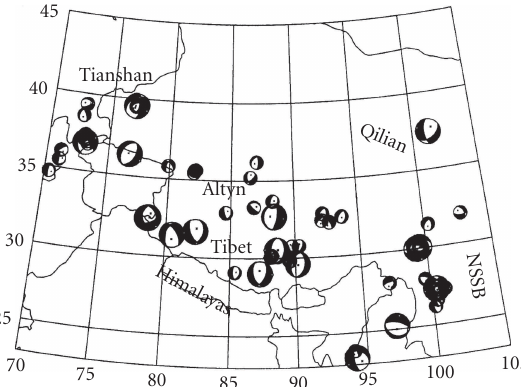
Figure 8: Distribution of the fault plane solutions for the normal- fault-type events (1933-2003, M ≥ 5) in and around the Tibetan plateau.